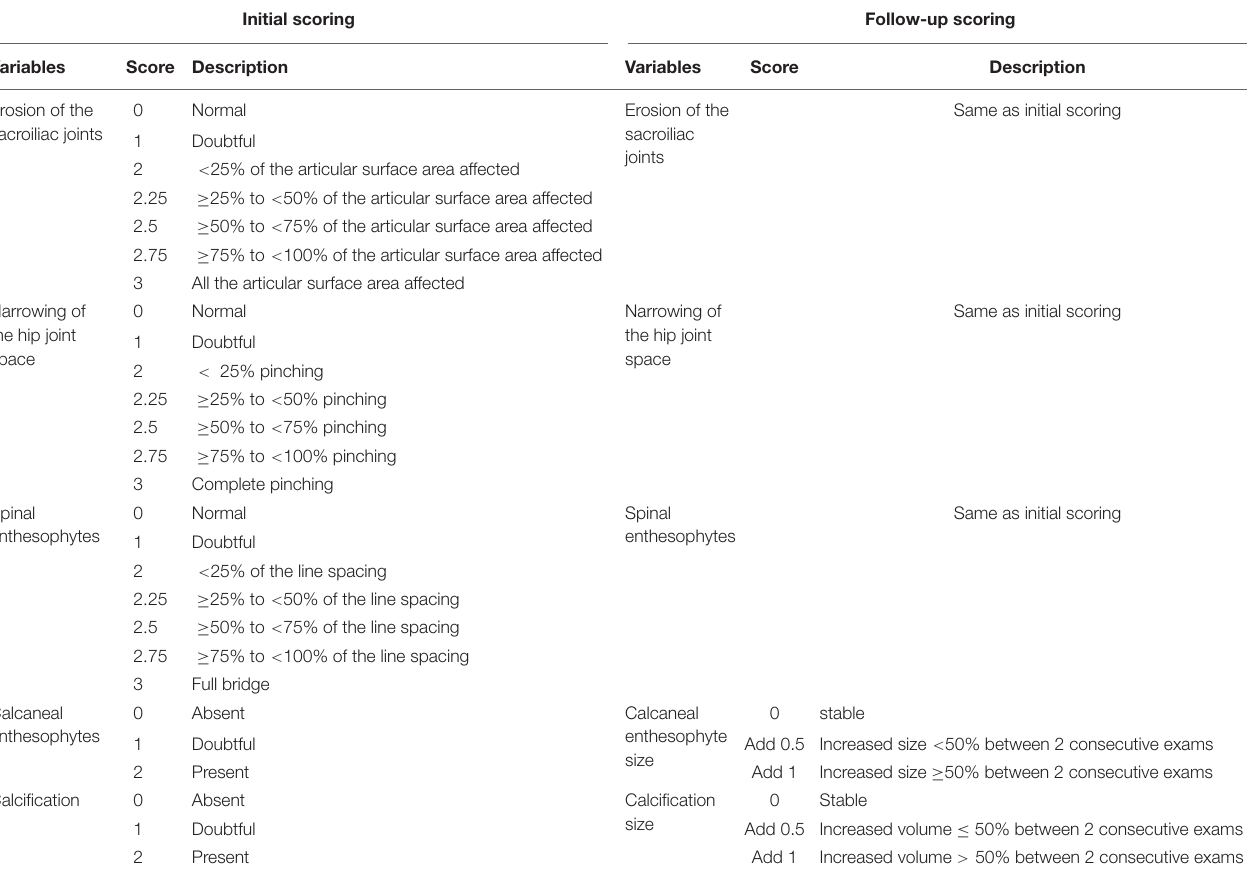
TABLE 1 | Scoring grid of enthesopathies, erosions, ossifications, and narrowing of